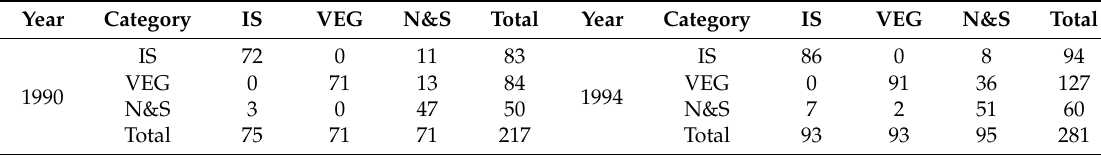
Table 4. Confusion matrix, overall accuracy and Kappa